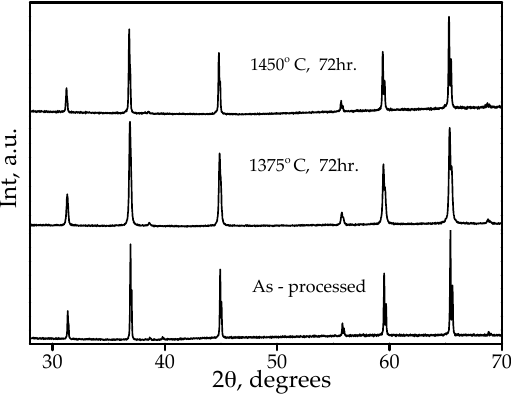
Figure 7. XRD spectra of as-processed and heat-treated to 1375 °C (72 h) and 1450 °C (72 h) samples.